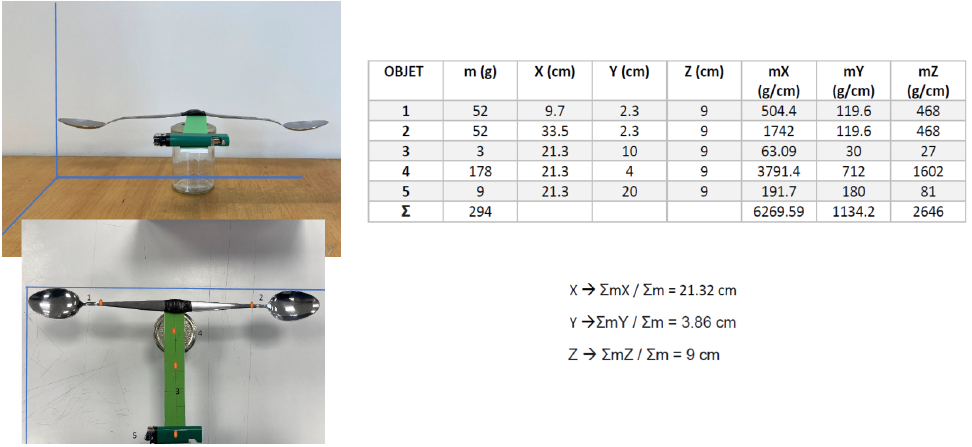
Figure 2. The equilibrium